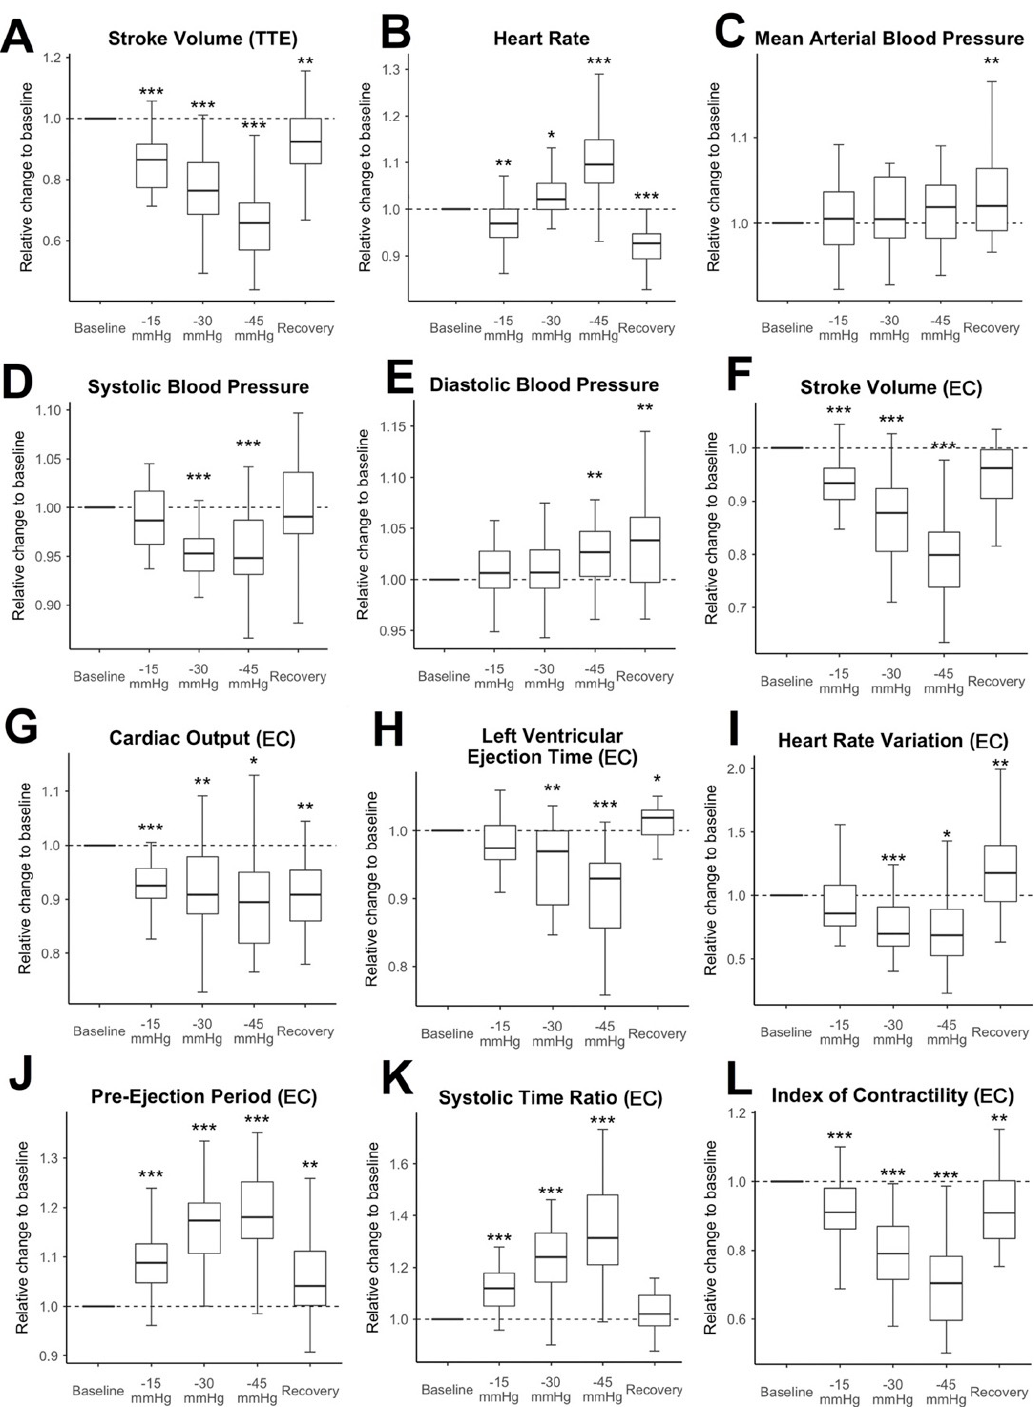
Figure 3. Time course of changes in the features relative to baseline: changes to the selected hemodynamic measurement values (one panel per value) over the course of the LBNP experiment relative to the subjects’ individual baseline measurement. The subfigures ( A – L ) describe Stroke Volume determined by TTE ( A ), the vital signs ( B – E ), and selected parameter determined by EC ( F – L ). The median baseline value is marked with a dashed line. Results of paired nonparametric tests compared to the baseline are indicated as follows: * = p ≤ 0.05; ** = p ≤ 0.01; *** = p ≤ 0.001. (EC): indicates values determined by electrical cardiometry; (TTE): indicates values determined by transthoracic